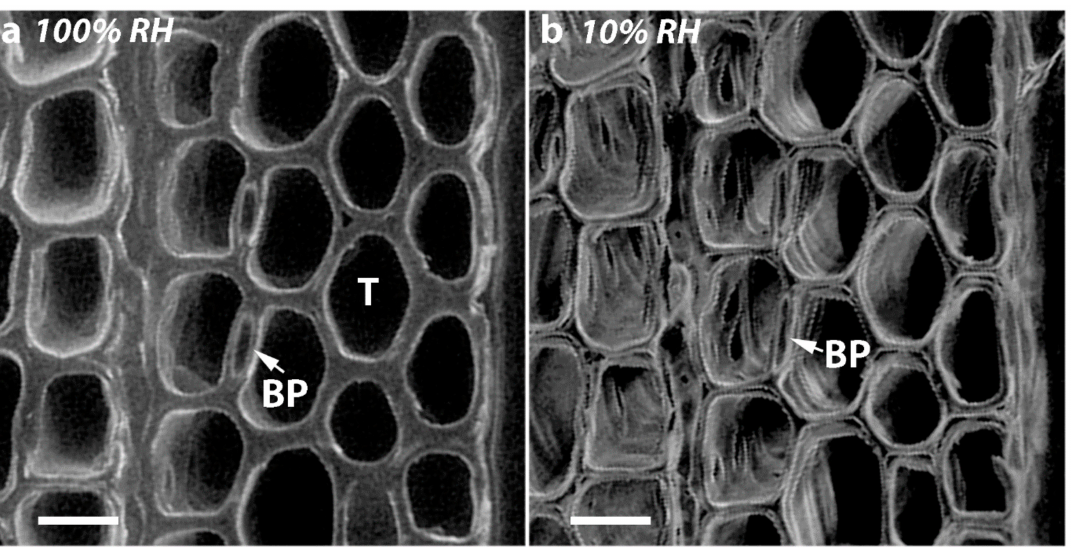
(Table 5). Comparison of micrographs of transverse surfaces of MCW1 at 100% and 10% RH showed the chambers of the bordered pits collapsed during drying (Figure 5). This collapse probably accounts, at least in part, for the decrease in aperture diameter after drying.